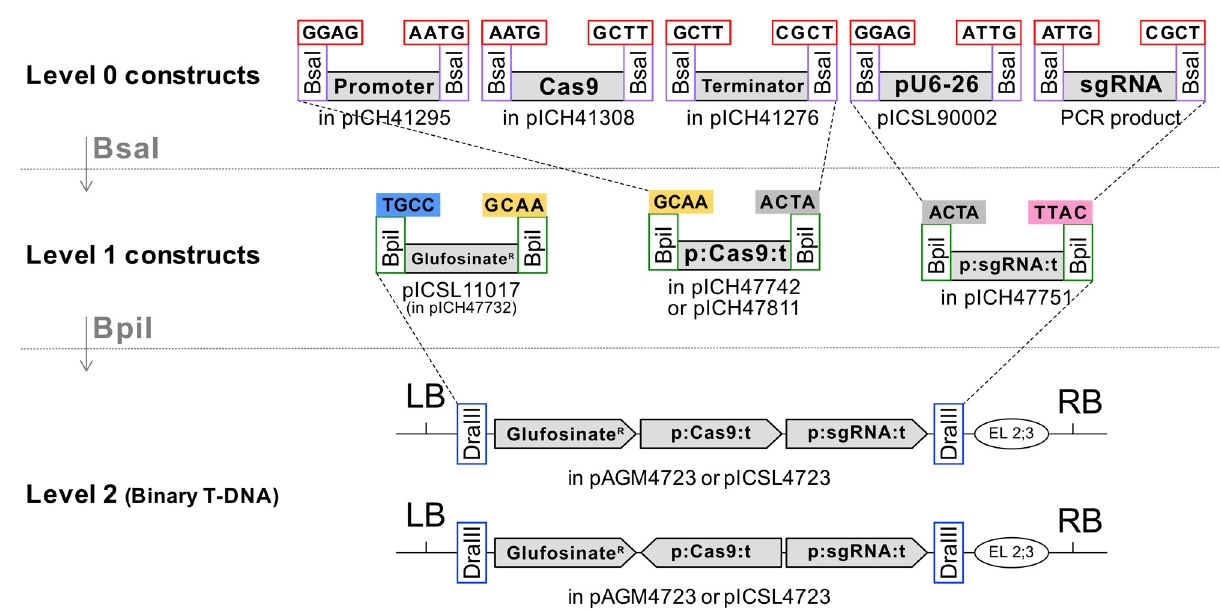
Fig 1. Golden Gate cloning method enables assembly of CRISPR modules in various combinations. Cas9 alleles, promoters and terminators were cloned into the indicated Level 0 acceptor vectors as described in Materials and Methods and were assembled in Level 1 acceptor vector pICH47742. sgRNAs targeting AtADH1 were amplified by PCR and assembled with the U6-26 promoter vector pICSL90002 in the same manner. Both Cas9 and sgRNA expression units were assembled in Level 2 acceptors pAGM4723 (not containing an overdrive sequence) or pICSL4723 (containing an overdrive ) along with a Glufosinate resistance plant selectable marker. An end-linker pICH41766 (EL2;3) was used to link the sgRNA expression unit to the Level 2 acceptor vector. For a “head-to-head orientation” of the sgRNA and Cas9 expression cassettes, Cas9 allele, promoter and terminator were assembled into pICH47811 instead of